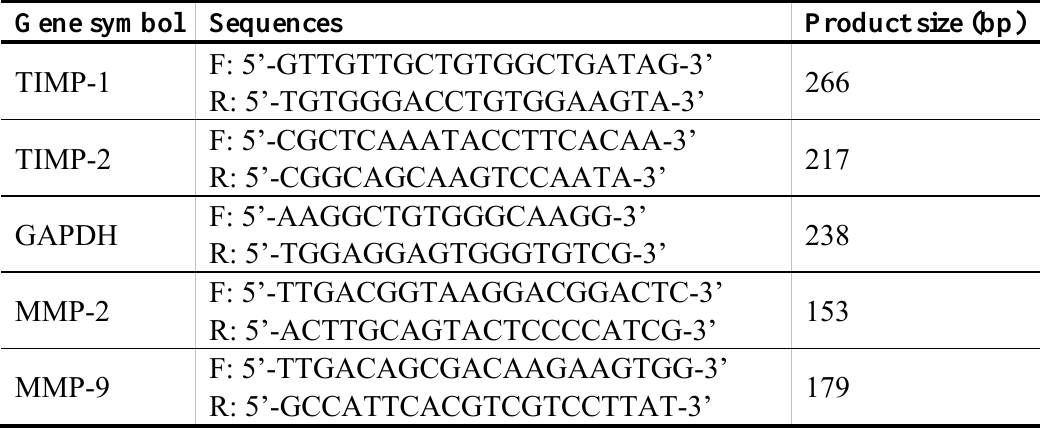
Table 1. Primer sequences used for quantitative Real-Time